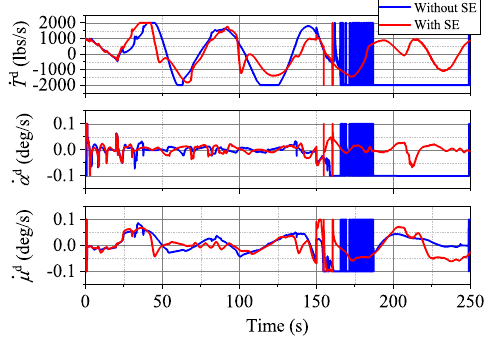
Figure 19. Results for ˙ T d , ˙ α d , and ˙ µ d .